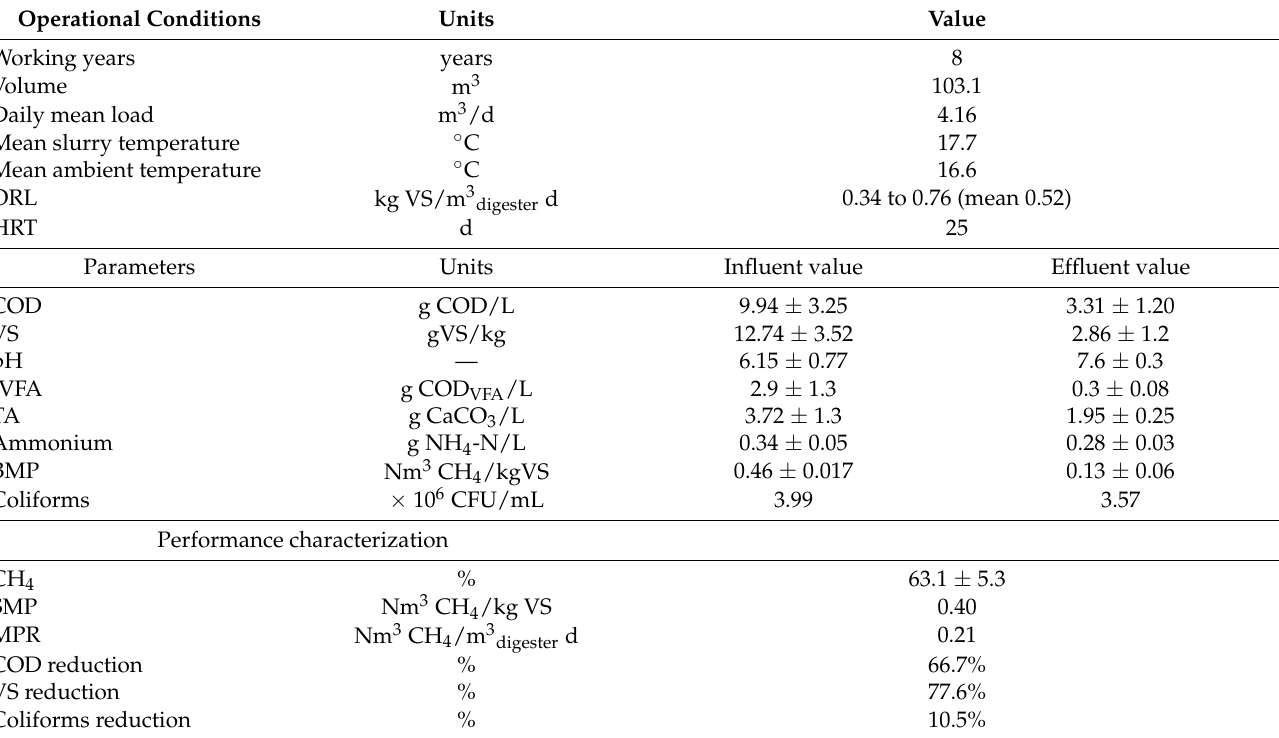
Table 2. Operational conditions, parameter measured and performance characterization of the full-scale low-cost tubular